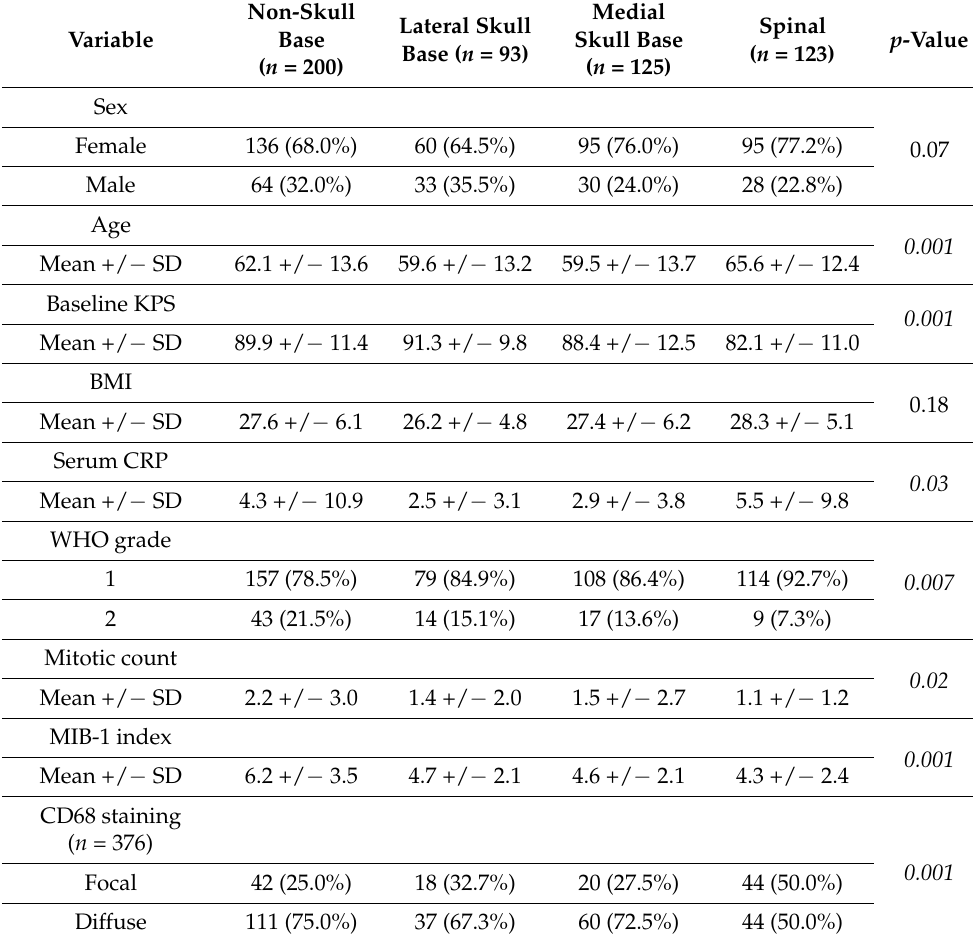
Table 2. Patient characteristics stratified by four major anatomic locations. Statistical analysis was performed using ANOVA and Fisher ´ s exact test